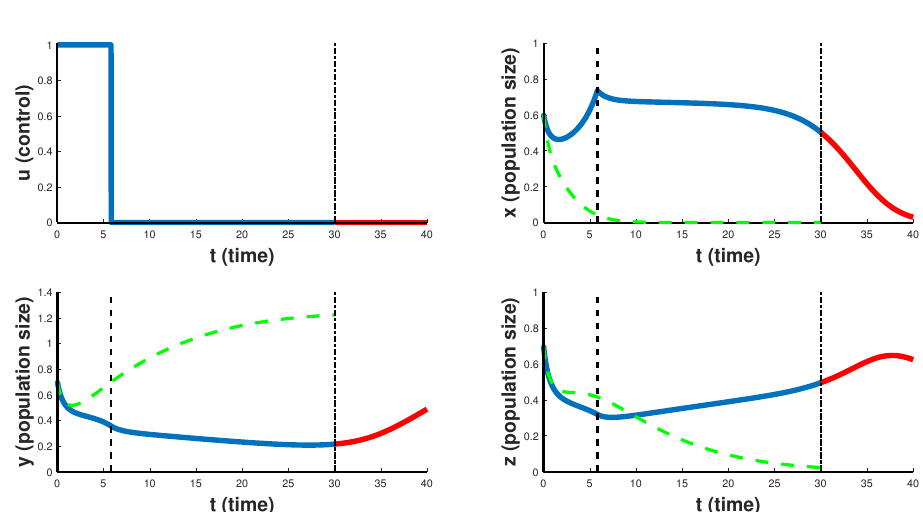
Figure 6. The optimal solutions x ∗ ( t ) , y ∗ ( t ) , z ∗ ( t ) and optimal control u ∗ ( t ) for the values of the parameters r = 0.6, p = 1.0, q = 1.1, η = 0.8, γ = 1.0, α 1 = 1.1, α 2 = 0.8, α 3 = 0.7, β 1 = 0.9, β 2 = 0.8, β 3 = 1.0, m = 0.3, µ = 1, u max = 1, T = 30 and the initial conditions x 0 = 0.6, y 0 = 0.7, z 0 = 0.7.